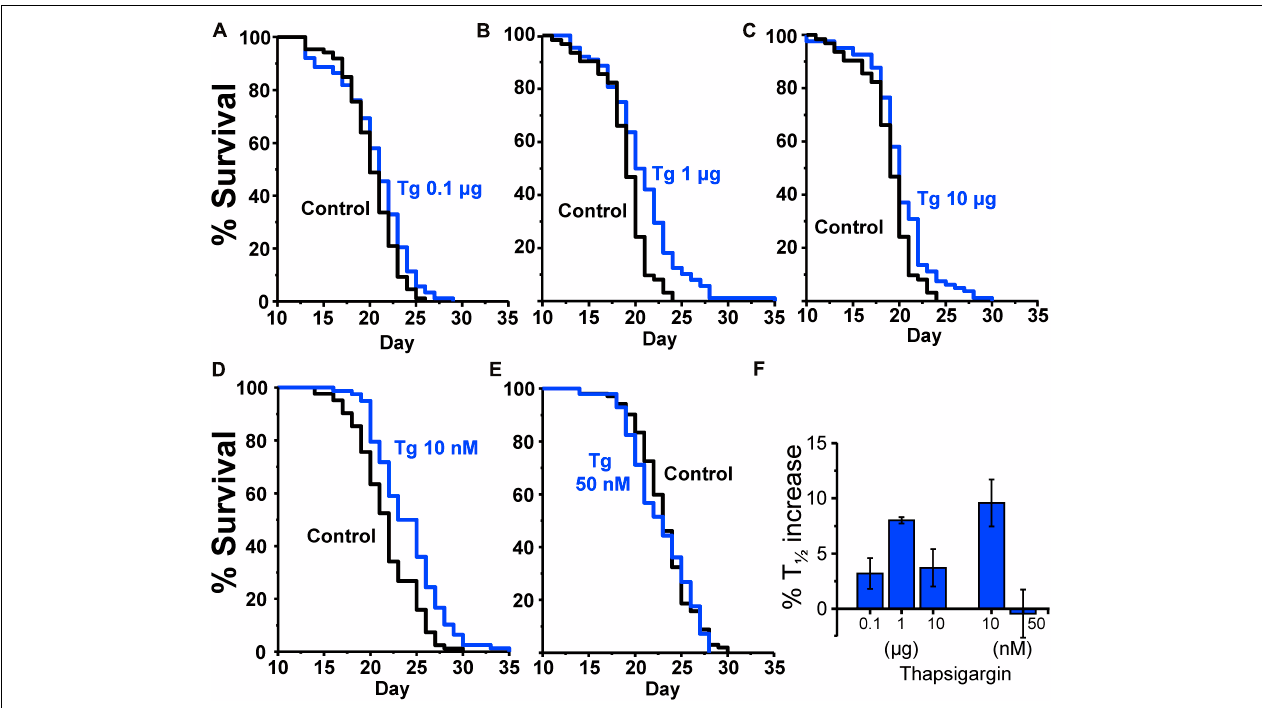
FIGURE 2 | Effects of thapsigargin on survival in C. elegans . (A–C) show representative survival plots corresponding to parallel lifespan assays performed using γ -cyclodextrin-inclusion compounds in the following conditions: Control/thapsigargin ( A :0.1 µ g; B : 1 µ g; C :10 µ g). (D,E) Show representative survival plots from Control/thapsigargin lifespan assays in which thapsigargin was directly added onto the OP50-seeded NGM agar (final concentration 10 or 50 nM). The assays correspond to those marked in bold in Table 2 . (F) Shows the mean increase in survival obtained in a series of lifespan assays of each kind as those shown in the figure (more details of each assay in Table 2 ).